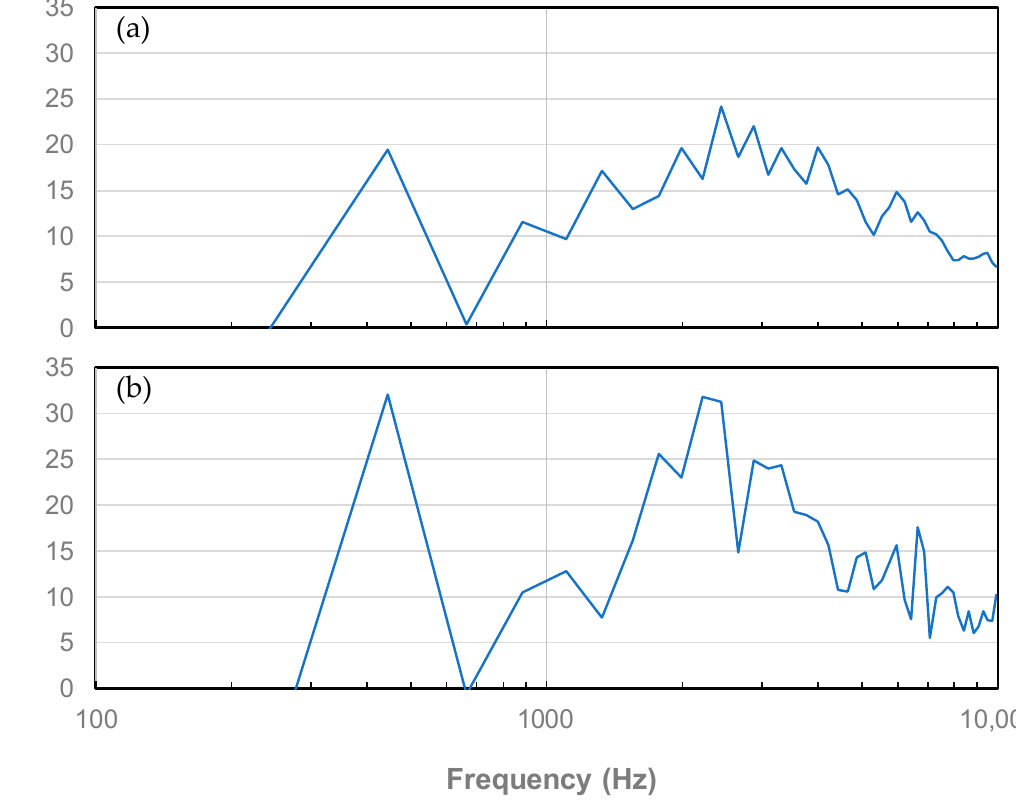
Figure 2. Hammered ( a ) and bowed ( b ) mobility plots of a violin for the A3 note averaged over octave bands.